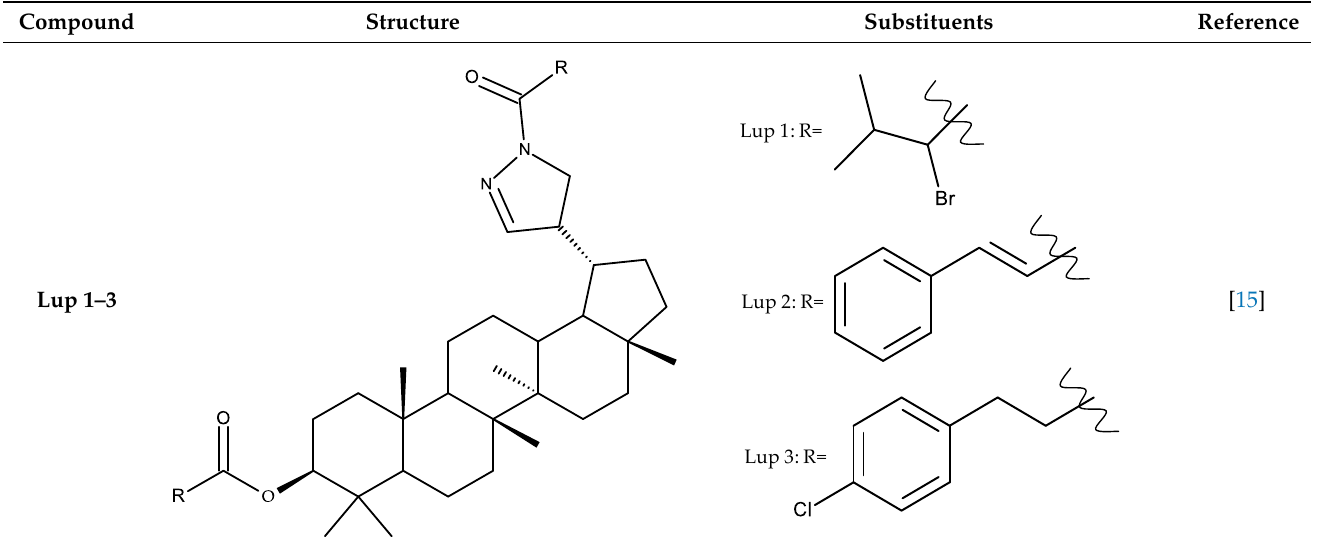
Figure 1. Frequent targets for the derivatization of lupeol. Table 1. Chemical structures of lupeol derivatives.